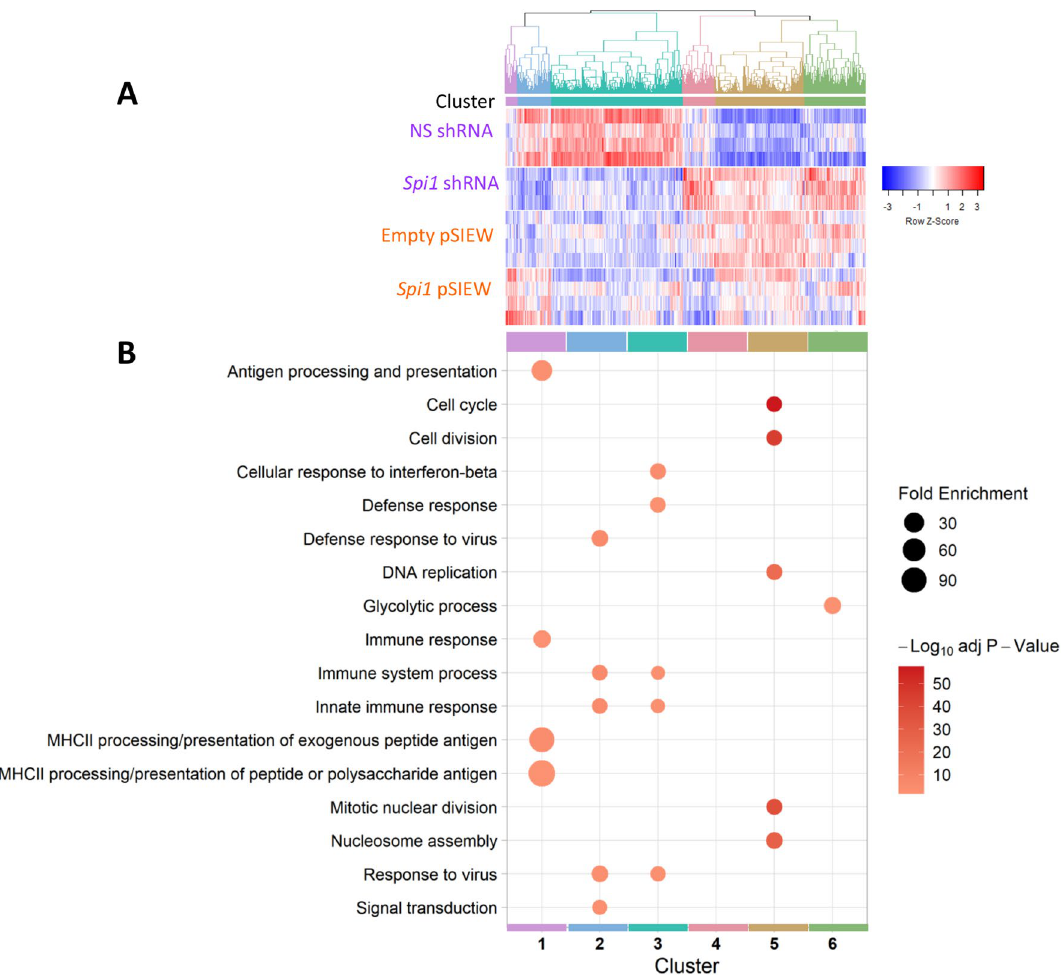
Figure 4. Hierarchical clustering analyses with the 20 most siginificantly changed biological pathways each cluster assessed using DAVID. ( A ) Hierarchical clustering of rows, where each row represents the scaled log 10 FPKM values for each gene, with dendrogram higlighting cluster boundaries. The Pearson correlation was used to calculate the Z-Scores and UPGMA agglomeration methods were used. These 6 clusters were produced using the cutree function at a height of 1.59. ( B ) The gene lists were assessed using DAVID and a bubble plot created to highlight the top 5 most significatly enriched pathways ( p value threshold of < 0.05) in each gene cluster. Cluster 1 contains genes that had increased expression following a higher Spi1 expression and are mainly linked to immune responses and MHCII antigen presentation. Cluster 2 appears to contain more of the Spi1 dose- sensitive genes and are enriched for viral/immune response signalling pathways. Genes in Cluster 3 had a lower expression in the Spi1 shRNA dataset and are related to immune response and interferon signalling pathways. Cluster 4 contained no significantly enriched pathways using the p ≤ 0.05 threshold. Cluster 5 contains multiple genes related to cell cycle and DNA replication pathways, whose expression was increased in the Spi1 shRNA samples. The bubble size denotes the fold enrichment and the colour Benjamini–Hochberg adjusted p values. Figures were made with the ‘tidyverse’ 37 , ‘gplots’ 42 , ‘plotly’ 43 , ‘dendextend’ 44 and ‘colourspace’ 45 packages in RStudio 39,40 , code adapted from 46,47 complete Markdown is available in Supplementary